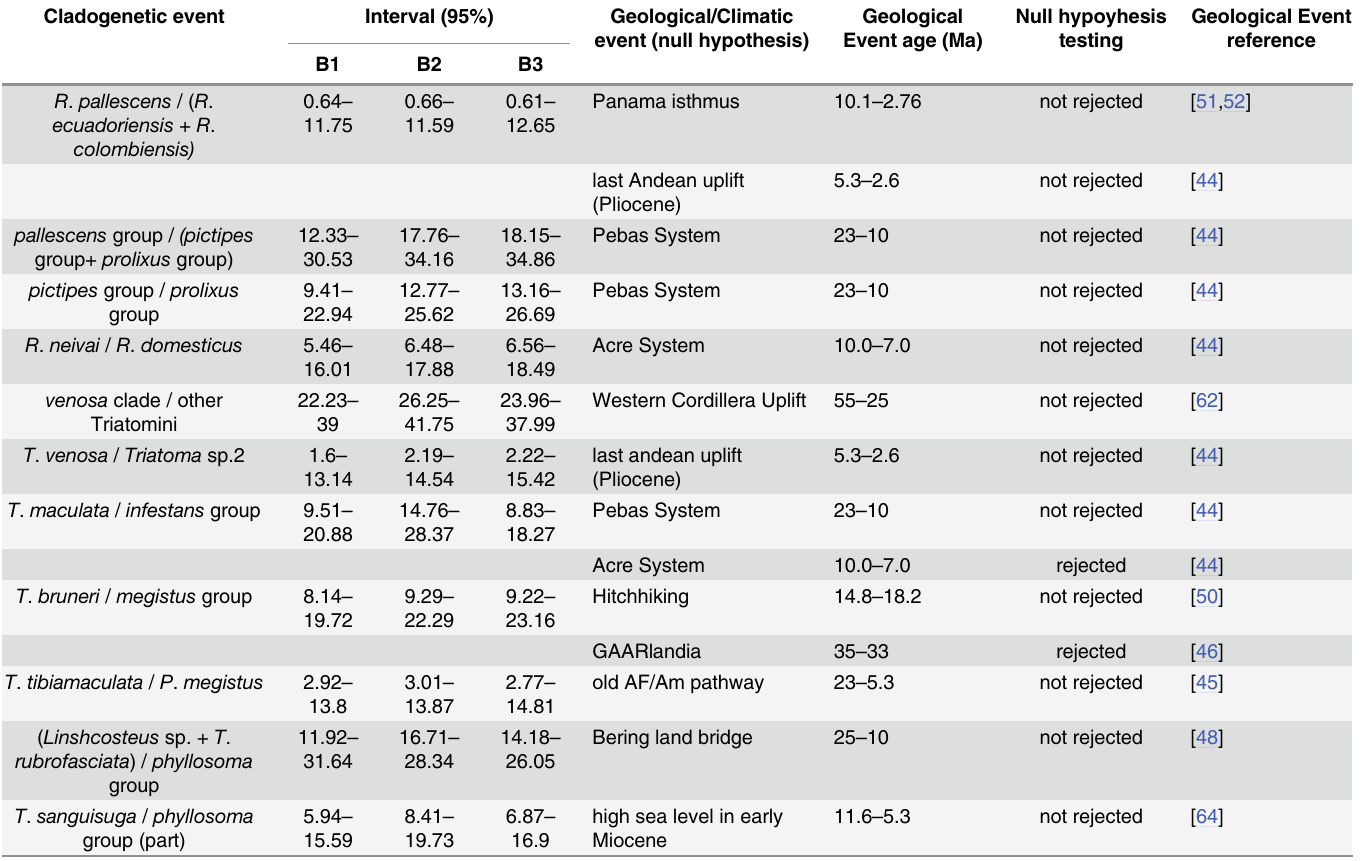
Table 3. Cladogenetic events tested in this study and the hypothetical vicariant events tested. / indicates the vicariant event identified and tested. Colums B1-3 indicate the 95% confidence interval estimated in Bayesian inference. Cladogenetic